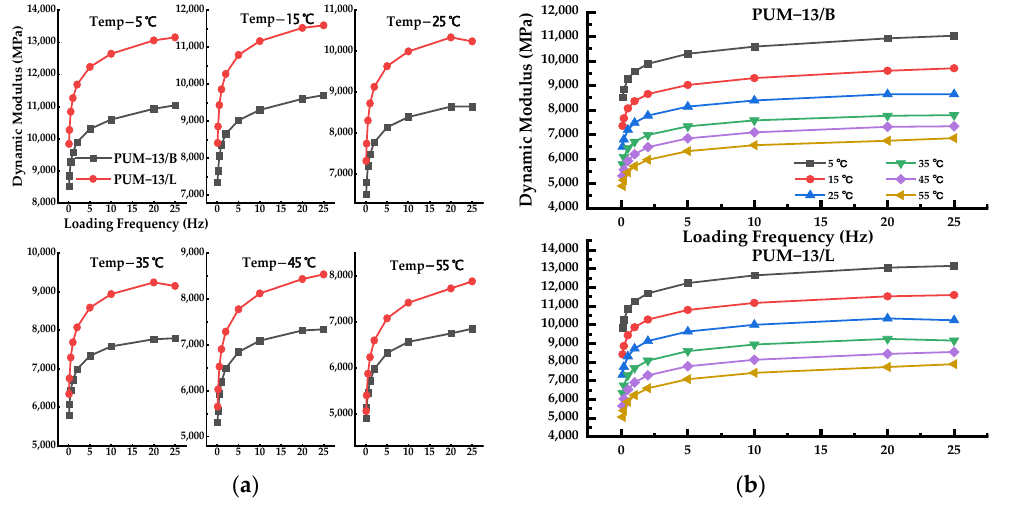
Figure 6. The dynamic modulus of the PU mixtures with the same gradation and different aggregate types. ( a ) dynamic modulus under different test temperatures, ( b ) dynamic modulus with different aggregate types.